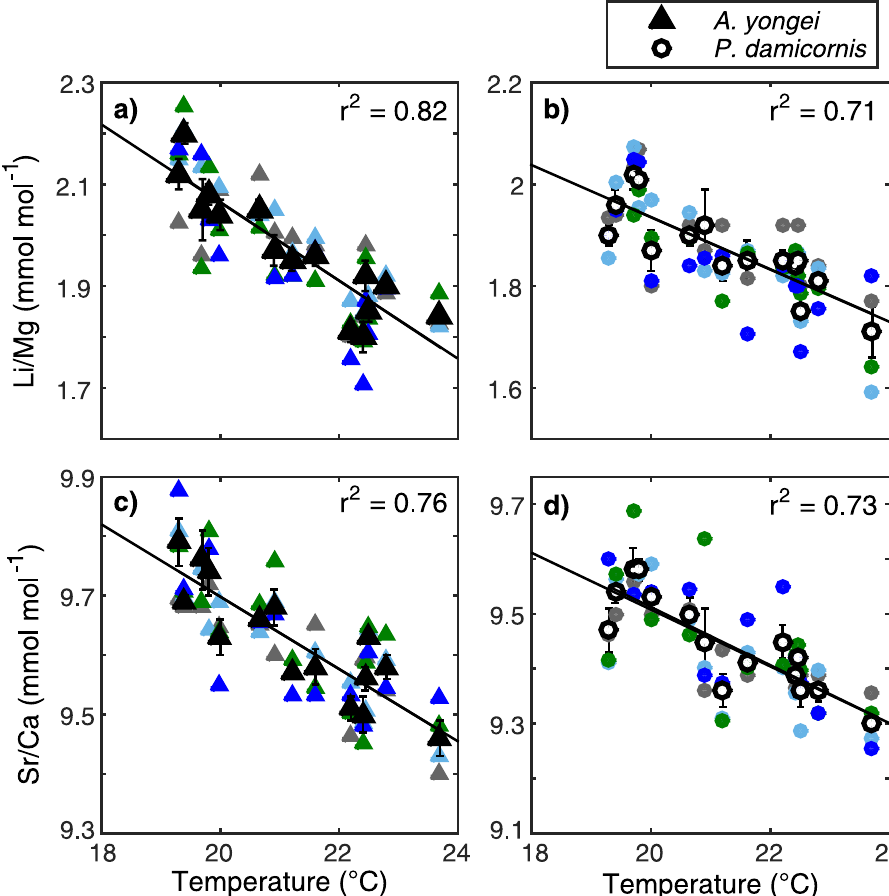
Figure 1. Measured Li/Mg and Sr/Ca in corals at Rottnest Island plotted against seawater temperature. ( a,b ) Li/Mg plotted against temperature with regression equation Li/Mg = − 0.08T sw + 3.63 for Acropora yongei and Li/Mg = − 0.05T sw + 2.99 for Pocillopora damicornis ( c,d ) Sr/Ca plotted against temperature with regression equation Sr/Ca = − 0.061T sw + 10.92 for Acropora yongei , and Sr/Ca = − 0.053T sw + 10.57 for Pocillopora damicornis . Coloured symbols represent each colony while the black symbols with lines denote the mean ( ± 1 SE; n = 4) for each time